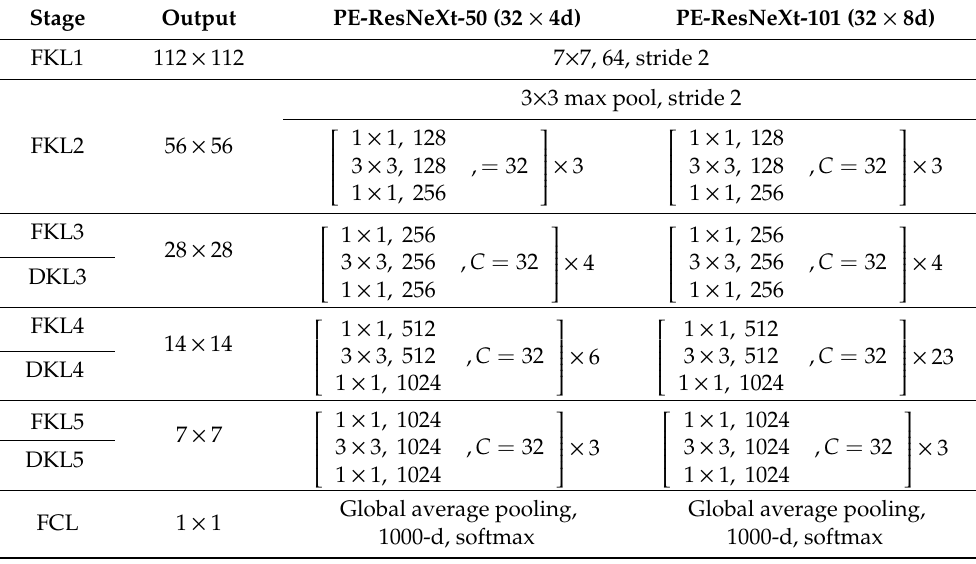
Table 1. Detailed structure of PE-ResNeXt.